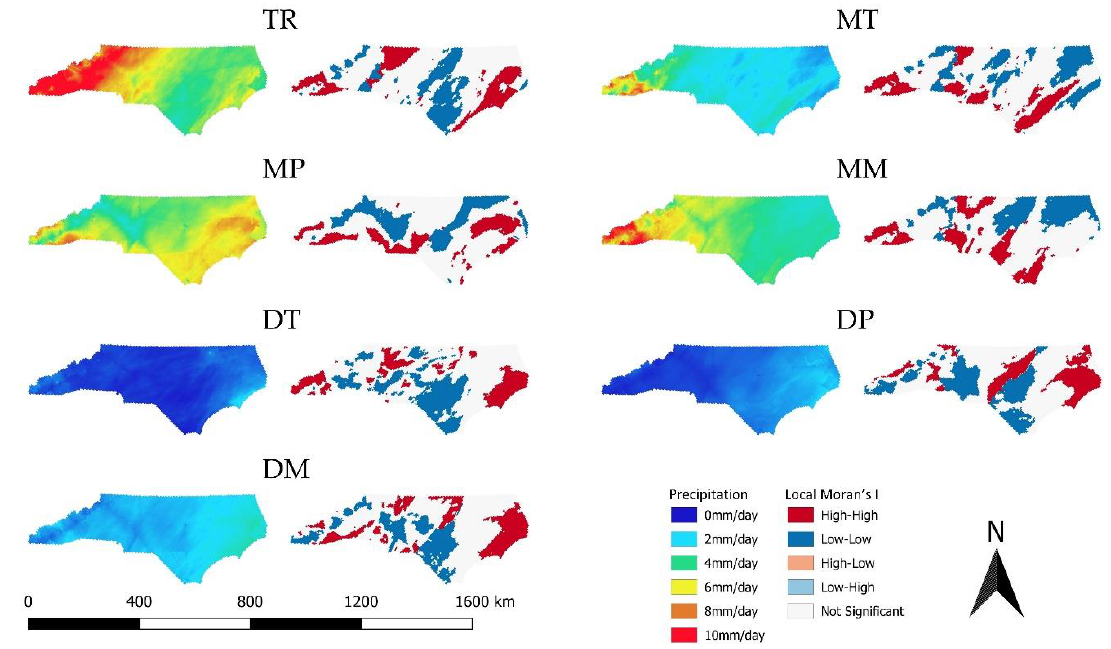
Figure 5. Winter (DJF) daily average precipitation ( left ) and spatial clustering analysis of precipitation ( right ) for each SSC air mass